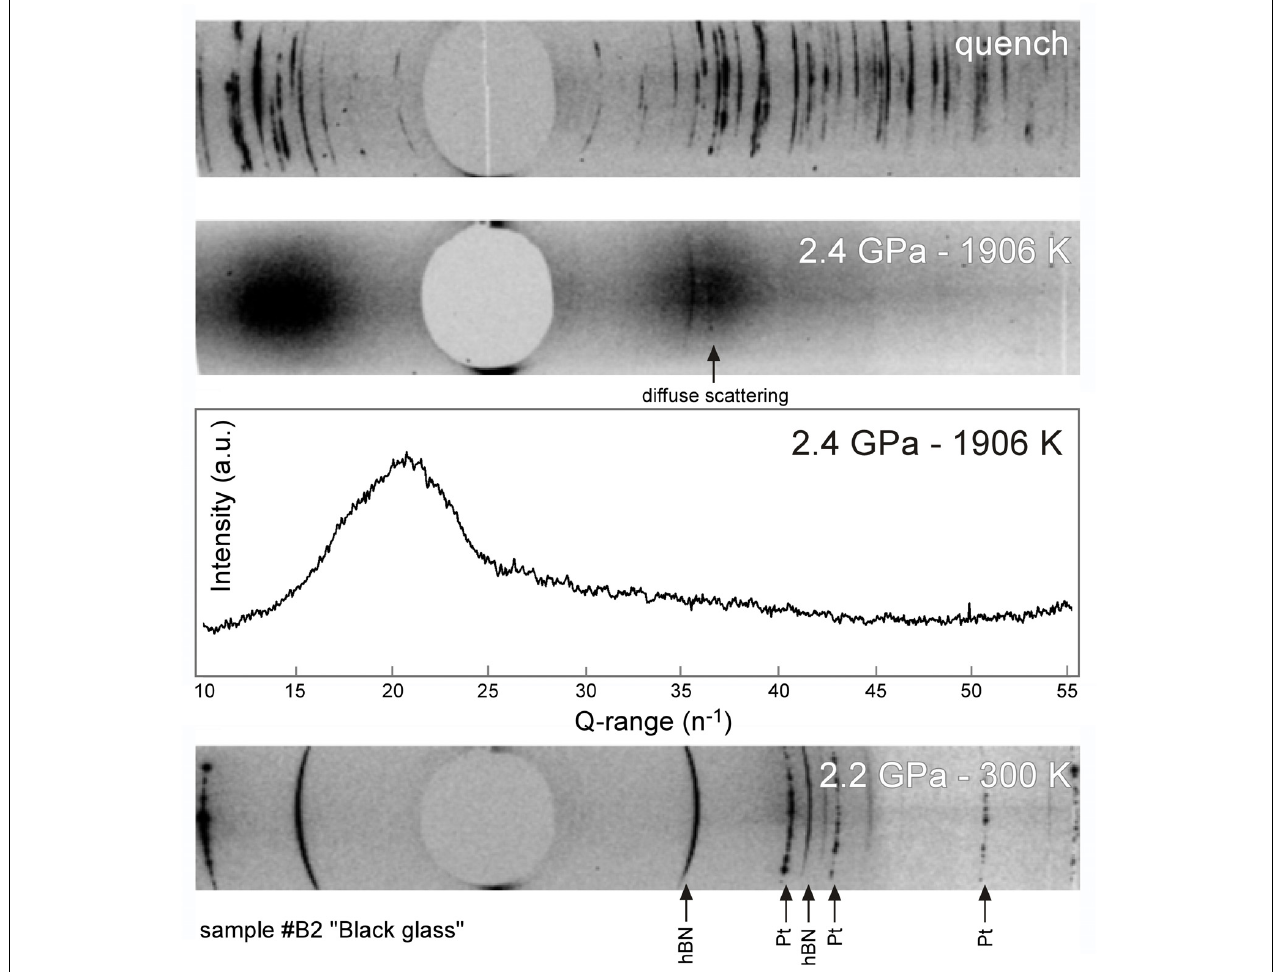
FIGURE 2 | Typical X-ray diffraction images acquired on sample B2, black glass composition; at (bottom) sub-liquidus conditions, showing diffraction lines of hBN and Pt calibrants; at (middle) superliquidus conditions of 2.4 GPa – 1906 K. Full melting is evidenced by a broad band of diffuse scattering and the absence of diffraction spots. The corresponding integrated intensity spectrum is plotted in Q-range scale. (top) After temperature quench, the sample is fully